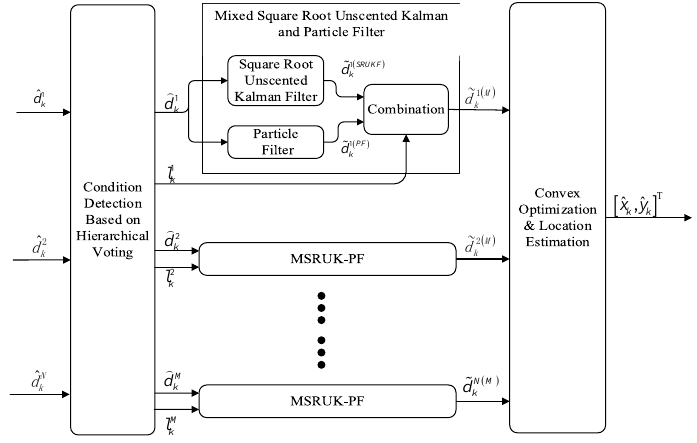
Figure 1. The flowchart for the proposed algorithm.